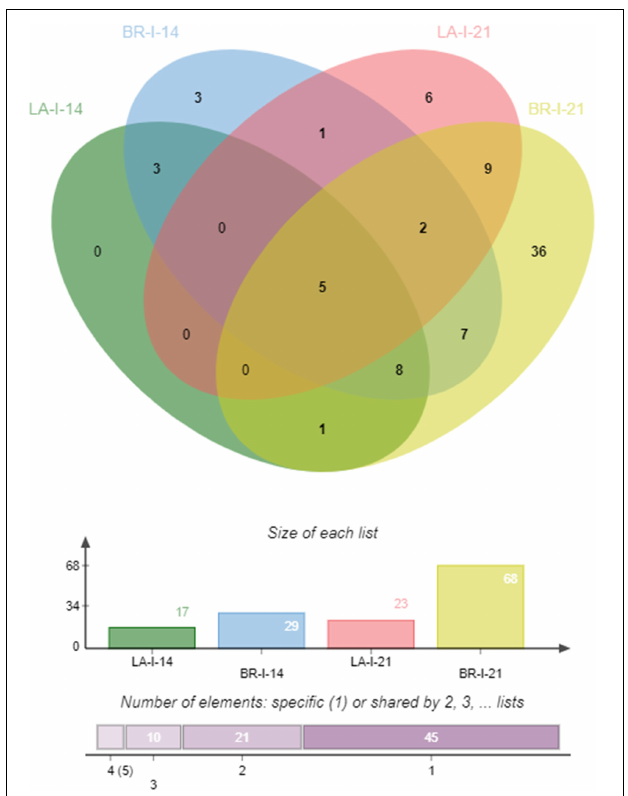
FIGURE 3 | Venn diagram of consistently regulated transcripts corresponding to secreted proteins. The Venn diagram depicts the number of P. brassicae transcripts with common, opposite and distinct expression patterns coming from the two B. napus hosts at 14 and 21 dai. LA-I-21 = ‘Laurentian’ inoculated 21 dai; BR-I-21 = ‘Brutor’ inoculated 21